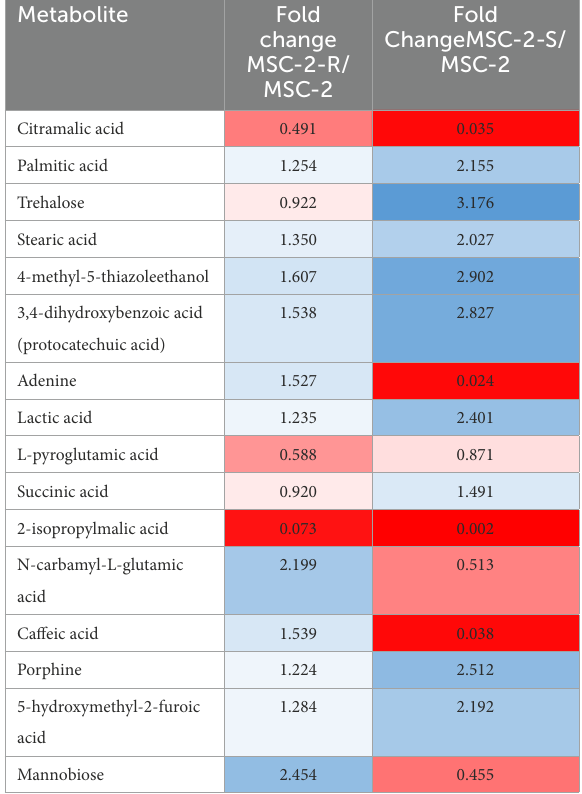
TABLE 2 Fold changes of metabolites in MSC-2-R and MSC-2-S communities.